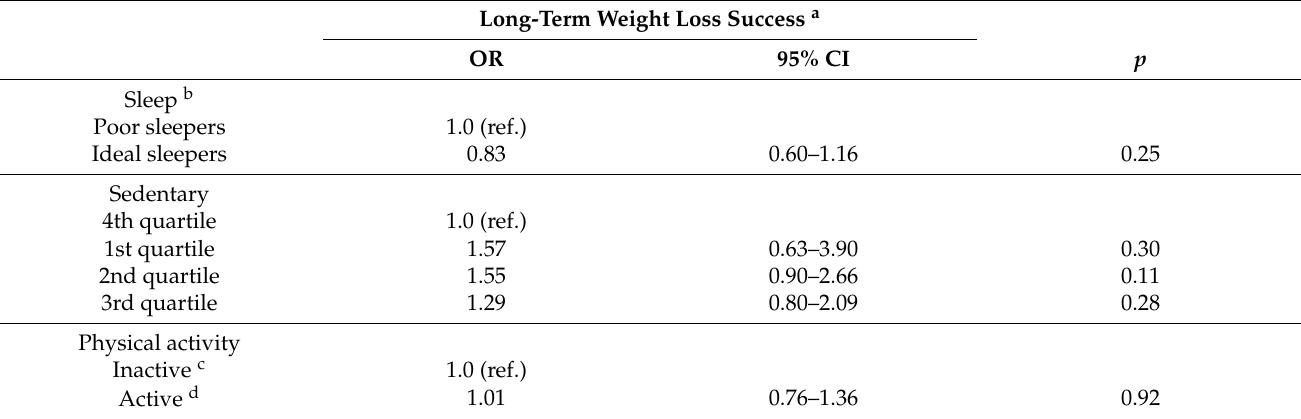
Table 3. Multivariable associations between sleep, sedentary time, and physical activity with long-term weight loss success. Long-Term Weight Loss Success